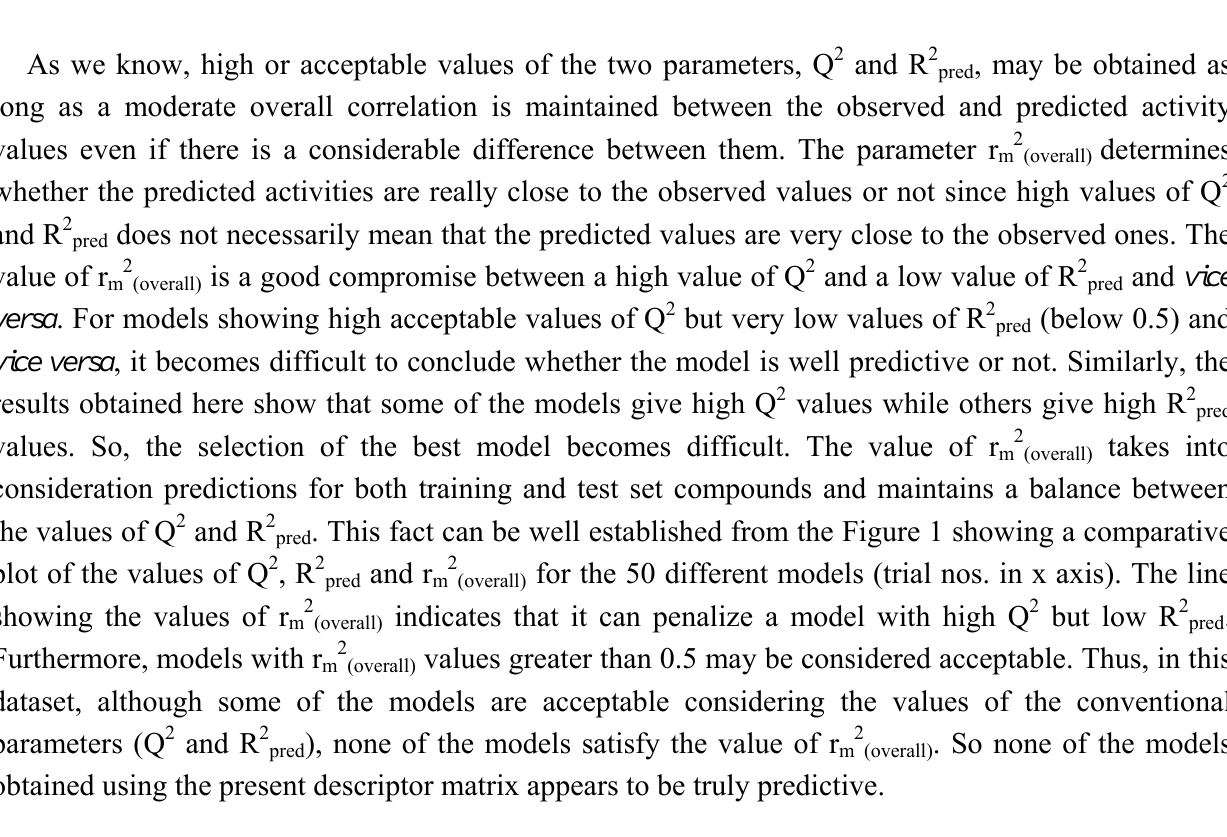
Figure 1. Comparative plots of Q 2 , R 2